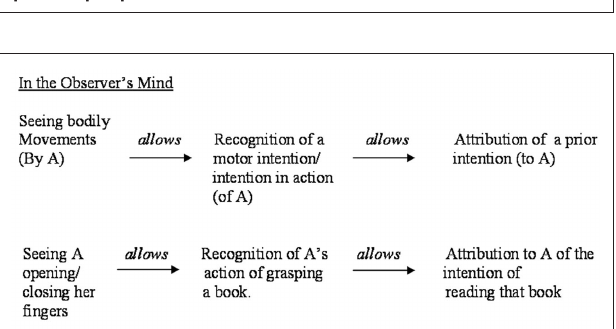
FIguRe 1 | The relation between prior and motor intentions, from first person’s perspective.